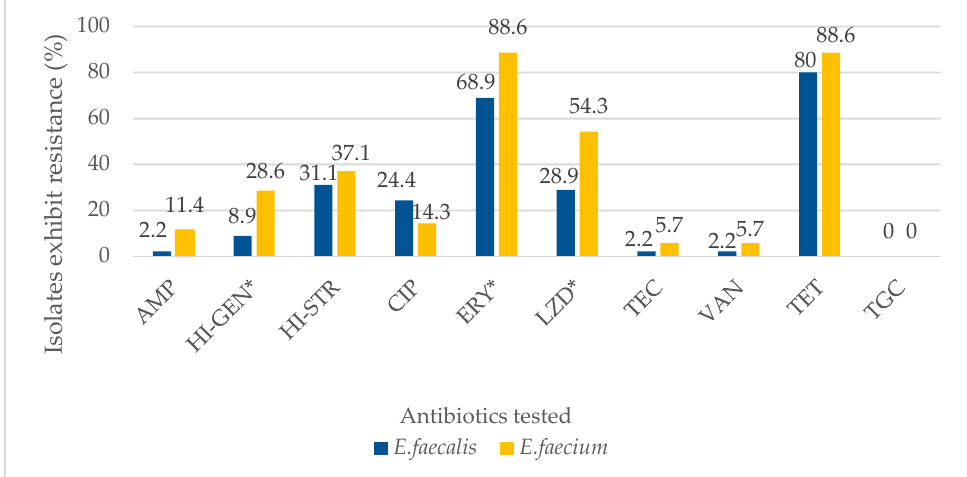
Figure 1. Rates of antibiotic resistance among E. faecalis and E. faecium isolates recovered from a poultry farm environment in Selangor. (AMP: ampicillin; HI-GEN: high-level gentamicin; HI-STR: ligh-level streptomycin; CIP: ciprofloxacin; ERY: erythromycin; LZD: linezolid; TEC: teicoplanin; VAN: vancomycin; TET: tetracycline; TGC: tigecycline; 1: E. faecalis ; 2: E. faecium ) . * There were significant differences between E. faecalis and E. faecium ( p < 0.05).